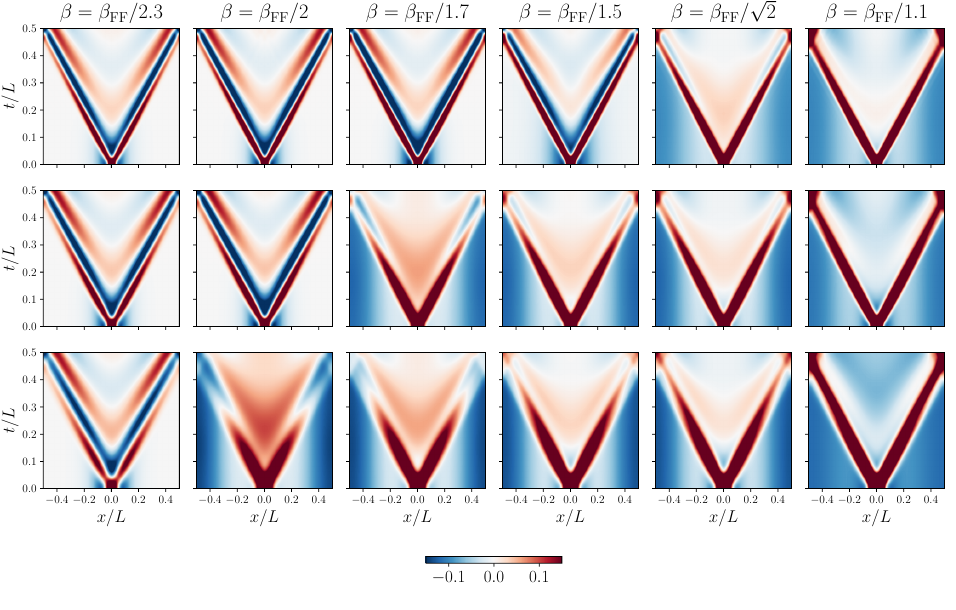
/ m = 12, m σ = 1 / 3, second row: A β FF 1 1 / m = 18, m σ = 2 / FF 1 1